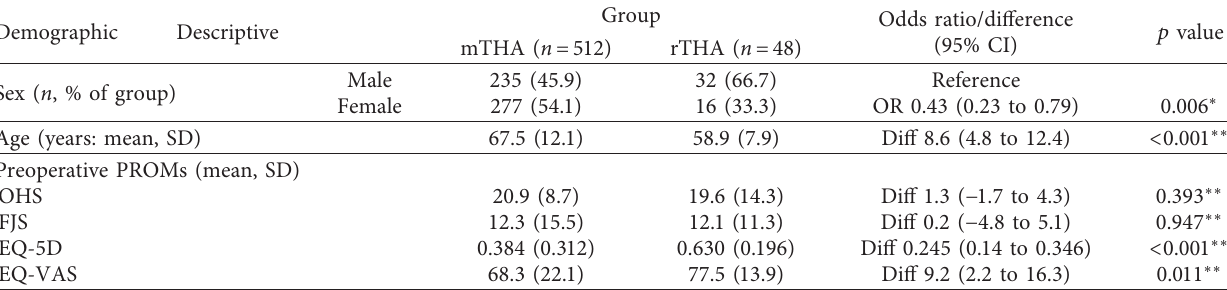
Table 1: Patient demographics and preoperative functional scores according to group.